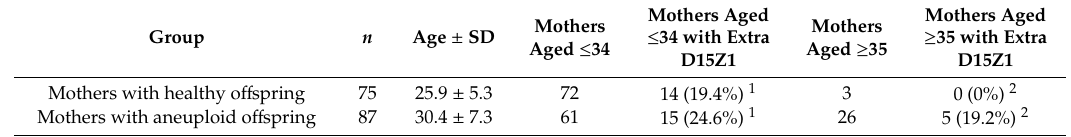
Table 2. Presence of extra D15Z1 signals according with the Mother age.